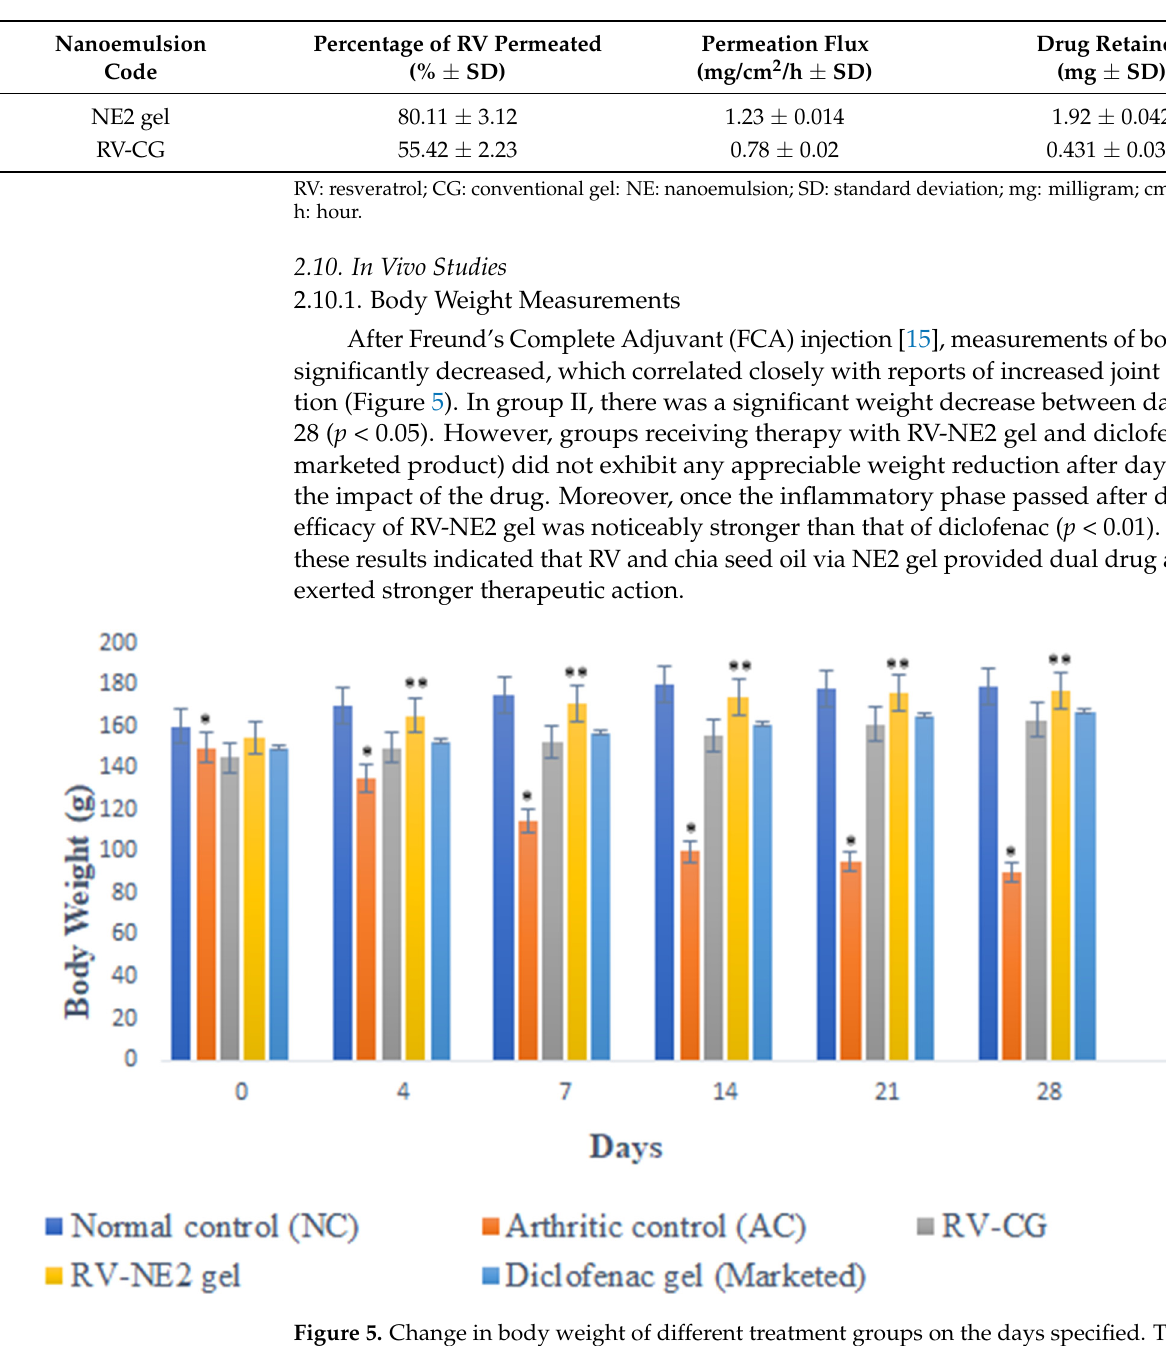
Table 4. Permeation profile and drug retention of RV in skin from RV-NE2 gel and RV-CG ( n = 3).